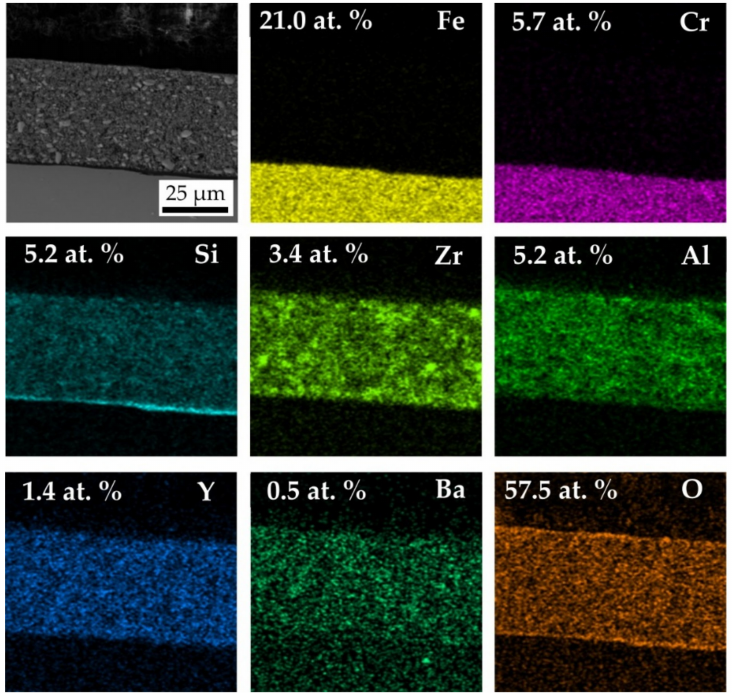
Figure 10. SEM / energy-dispersive X-ray spectroscopy (EDX) of D2-PP coatings documenting distribution of elements in the coating and in